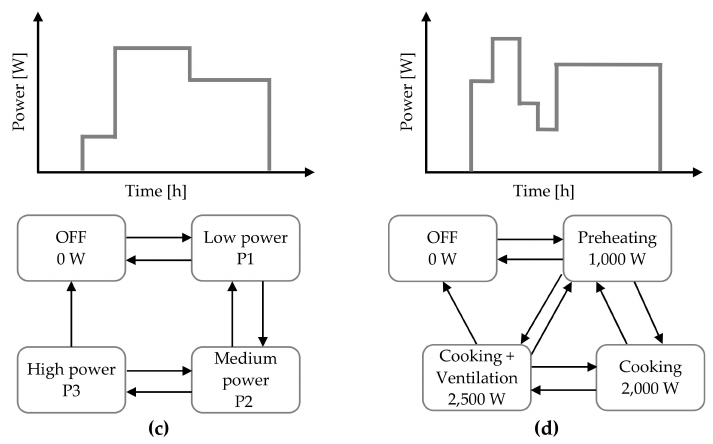
Figure 3. Finite state models: ( a ) two states model e.g., electric heating, toaster; ( b ) two operating modes appliances, e.g., lamp; ( c ) multiple states appliances e.g., devices on battery (with battery in